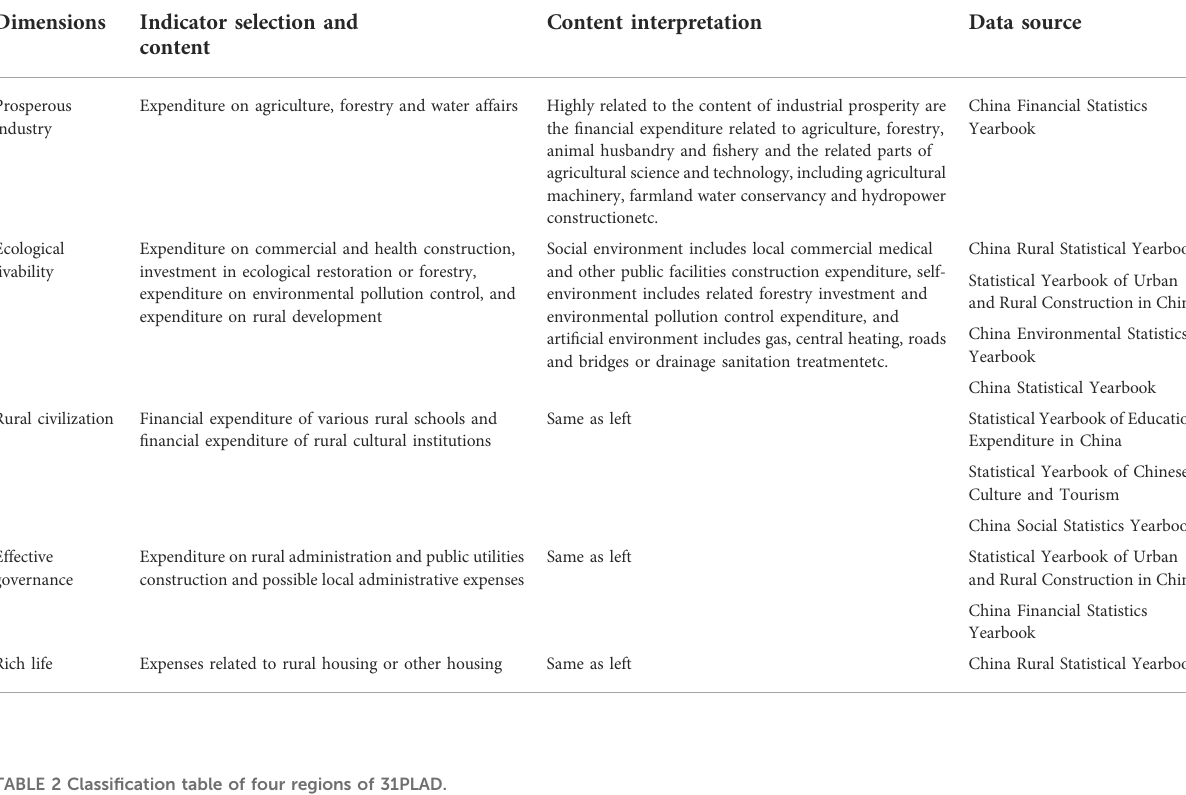
TABLE 1 Selection of indicators of each dimension.